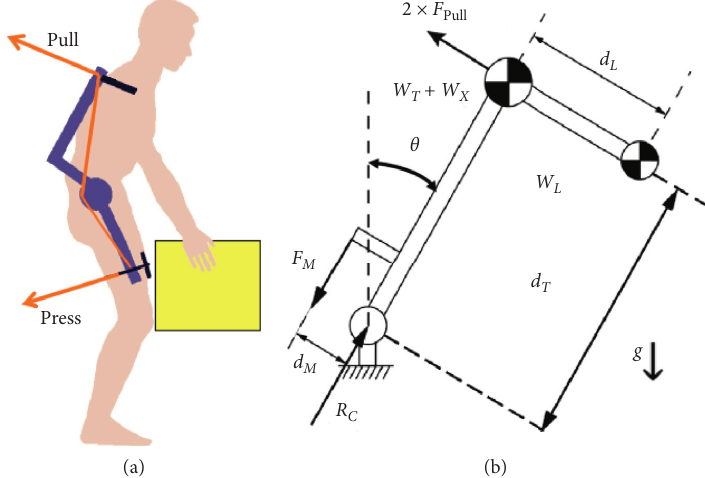
Figure 3: (a) Schematic diagram of the principle of exoskeleton assistance. (b) Mechanical model of exoskeleton assistance. The orientation angle of the torso with respect to the direction of gravity, defined as zero corresponding to upright positions and positive for forward bending; θ is the angle of users’ lumbar motion; F M is the contraction force developed by the spinal muscles; R C is the compression on the lumbar disc, represented by joint reaction force along the torso; W T and W L are the masses of the torso and the external load, respectively; W X is the mass of ALE; d M is the distance between the rotation joint and the line of action of the muscles; d T is the distance of the centre of mass of the torso from the rotational joint; d L is the constant distance of the centre of mass of the load from that of the torso; F assistive